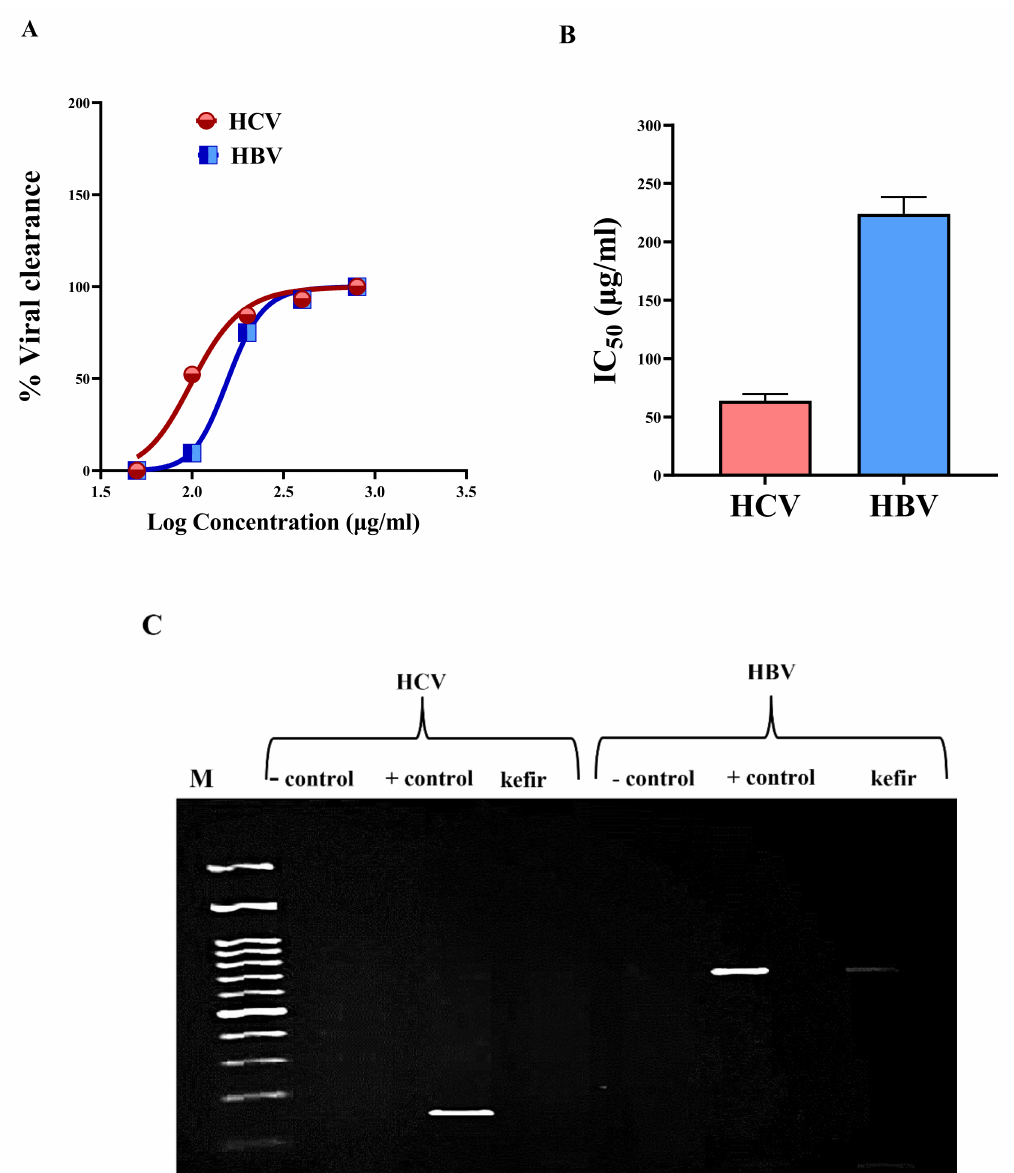
Figure 7. Antiviral activity of kefir. ( A ) Dose–response curve of anti-HCV and anti-HBV activities of kefir extract. ( B ) The estimated IC 50 of kefir extract against HCV and HBV. All data were demonstrated as mean ± SEM. ( C ) Gel electrophoresis images of nested PCR for viral hepatitis-infected cells after treatment with kefir extract (400 µ g/mL) compared to the negative ( − ) and positive (+) controls of viral-infected